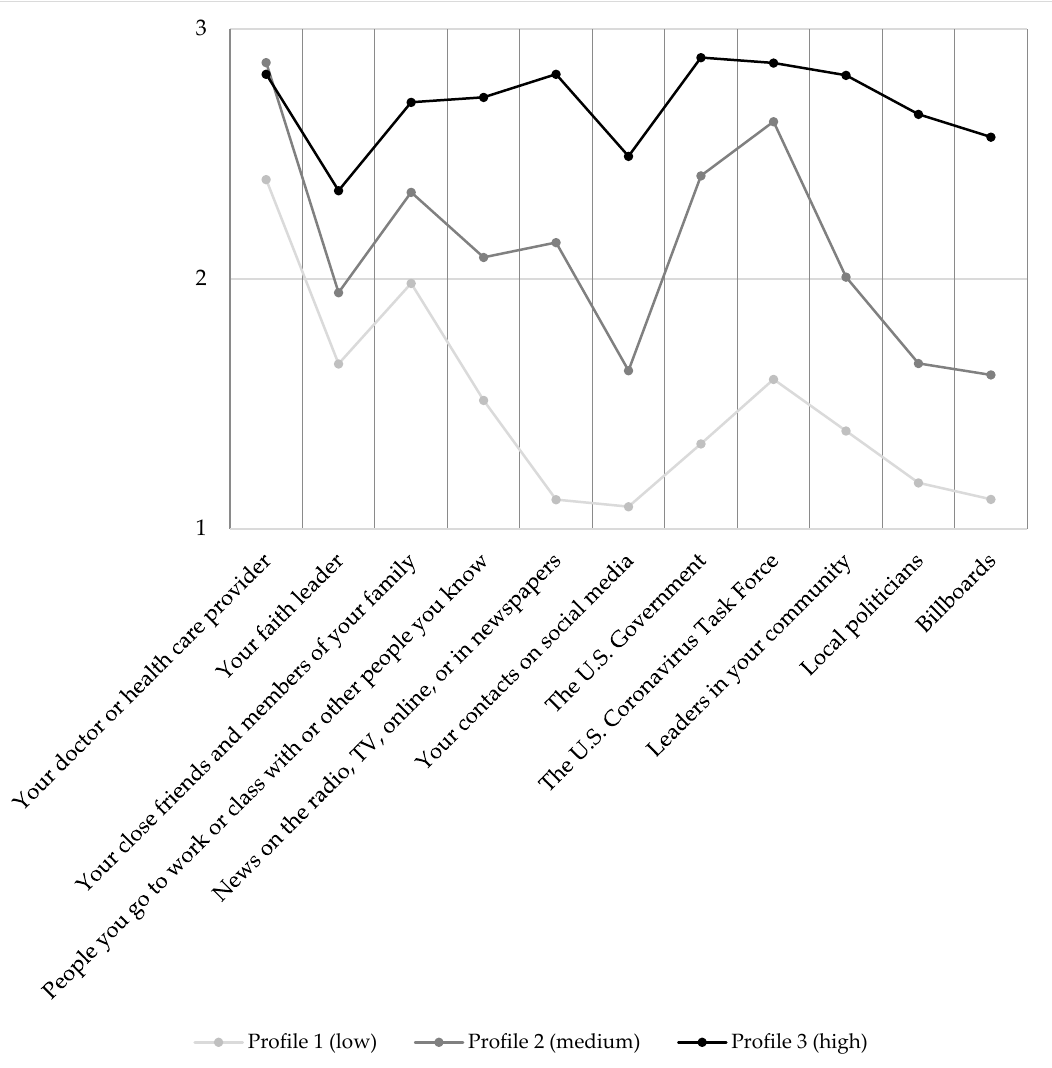
Figure 1. Visual display of LPA results of the 3-class solution of 11 trusted sources of information. Note: Profile 1 ( n = 80), Profile 2 ( n = 147), Profile 3 ( n = 52).